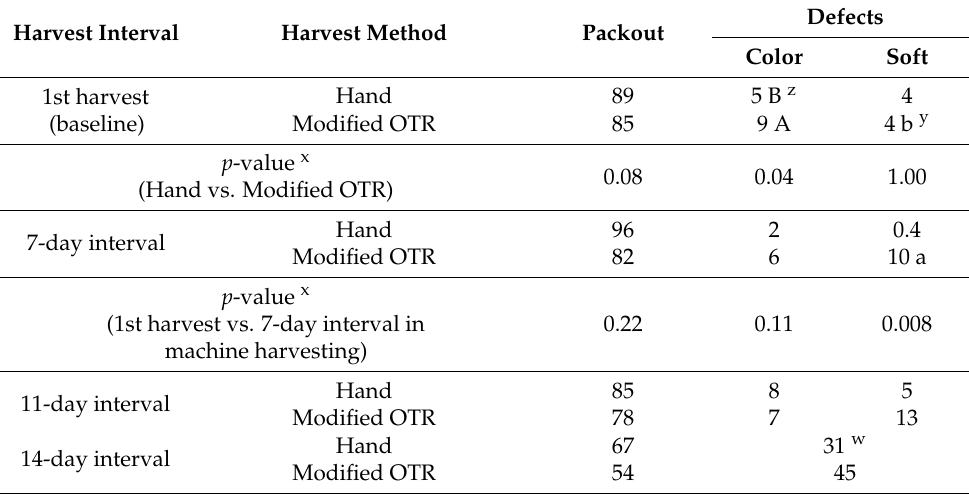
Table 3. Packout, color, and soft defects of ‘Liberty’ northern highbush blueberry in 2020. Fruits were harvested at 7-, 11-, and 14- day harvest intervals by hand or using a modified over-the-row (OTR) harvester with a patent-pending elastomeric polymer installed on catching surfaces in northwest Washington. The first harvest was the baseline from which interval treatments were established. Data are reported in percentages.